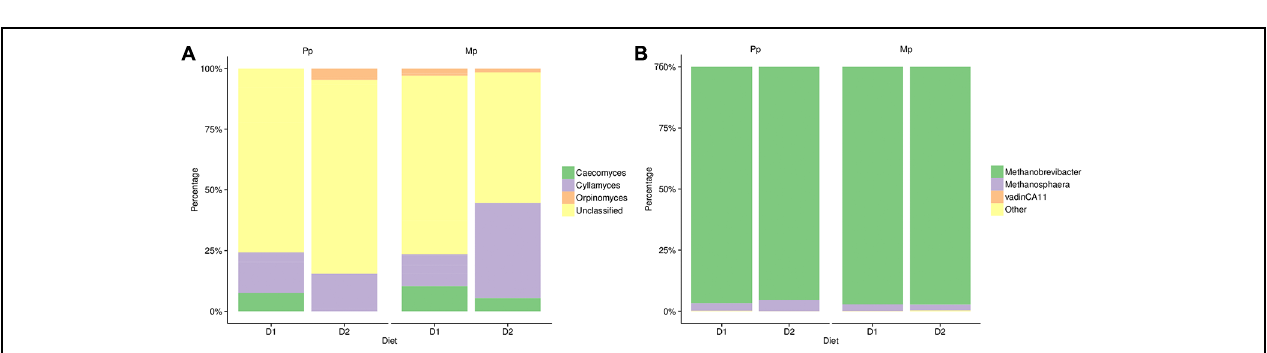
FIGURE 3 | Phylogenetic composition of (A) anaerobic fungi and (B) Methanogenic Archaea based on study group and diet. Sample identifiers are same as used in Figure 1